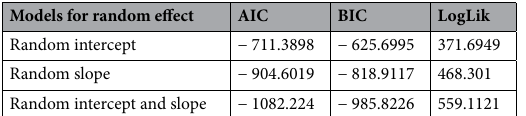
Table 2. Selection of random effects to be included in the linear mixed